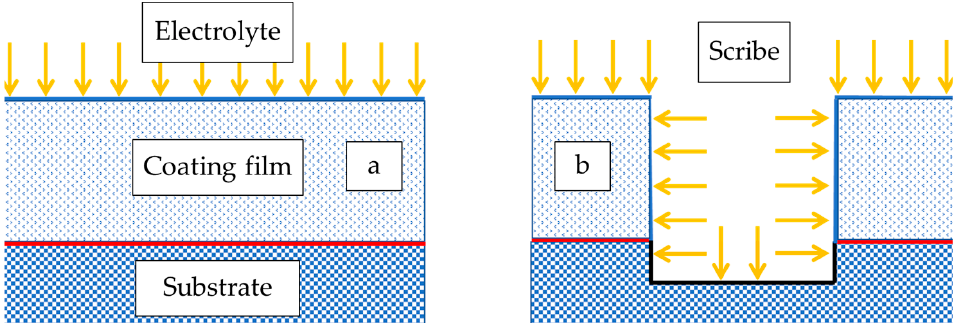
Figure 9. Schematic of two different exposure conditions and damage mechanisms arising in ( a ) electrochemical tests and ( b ) neutral salt spray tests.